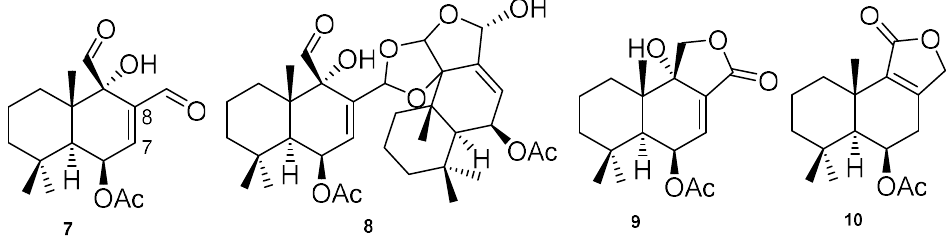
Figure 3. Cytotoxic drimanes against P388- and nasopharynx cancer cells (Eagle’s 9KB-cells) [45,46]. Nomoto et al. isolated drimane lactones and lactams from Cinnamosma fragrans and evaluated their cytotoxicity against A549 carcinoma cells (Figure 4) [47]. Lactone 11 was an increase in cytotoxic activity due to improved bioavailability.